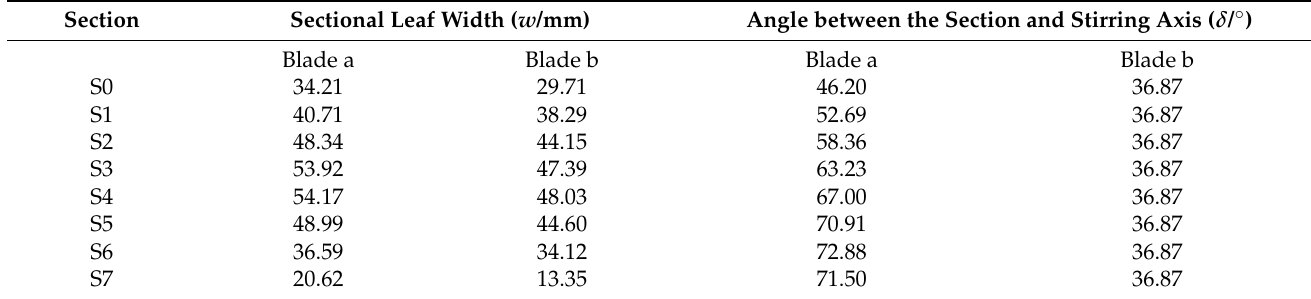
Table 1. Parameters of two kinds of propeller blade structures.